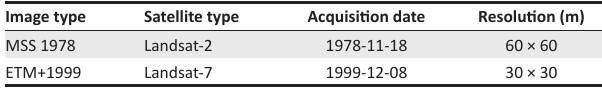
TABLE 1: The data on satellite